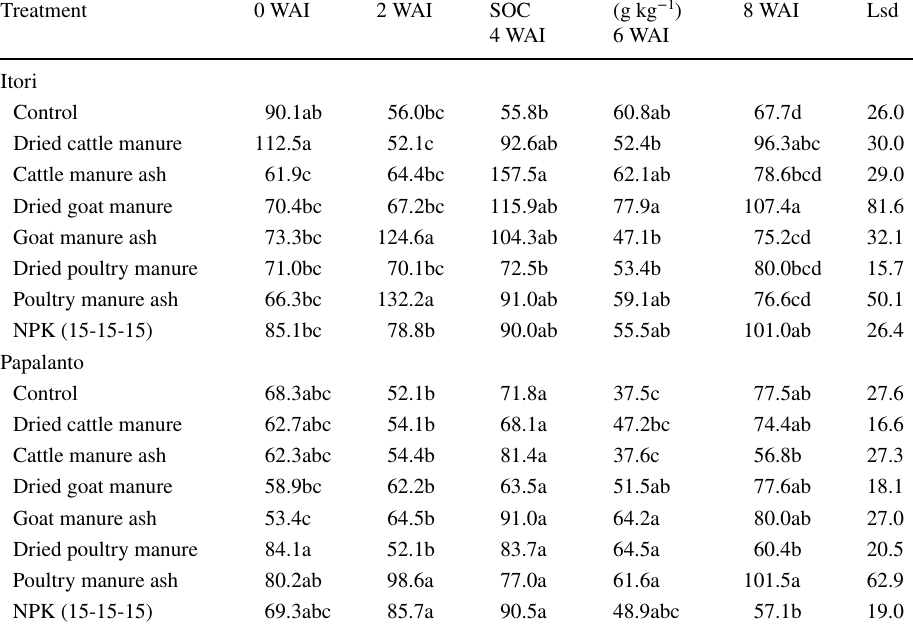
Table 3 Effect of amendments and incubation time on organic carbon of soils from Itori and